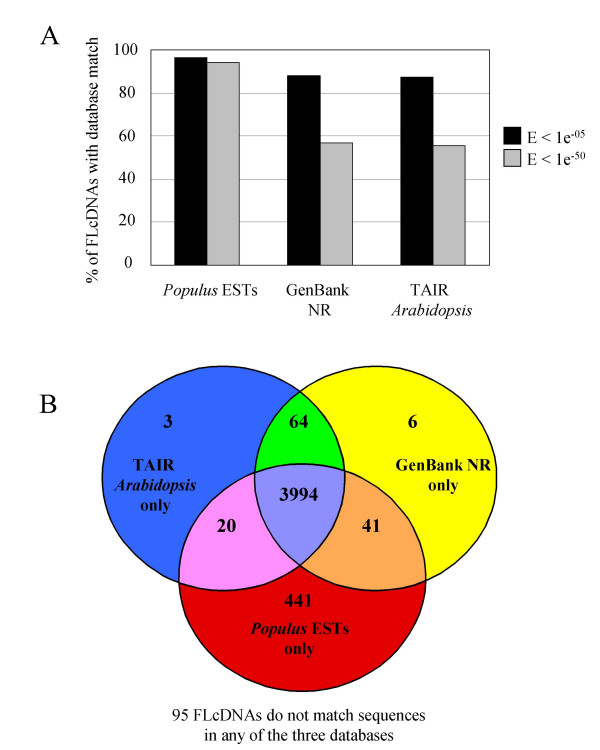
Sequence annotation of 4,664 high-quality poplar FLcDNAs against published databases. Panel A shows the percentage of FLcDNAs with similarity to entries in three databases using expect (E) value thresholds of < 1e-05 and < 1e-50: matches to previously published poplar ESTs (i.e., ESTs available in GenBank, excluding ESTs from this study) identified by BLASTN; amino acid sequences in the non-redundant (NR) division of GenBank identified by BLASTX; and The Arabidopsis Information Resource (TAIR) non-redundant Arabidopsis peptide matches identified by BLASTX. Panel B shows a Venn diagram of distinct and overlapping patterns of sequence similarity against the three databases (public poplar ESTs, TAIR, NR) at a BLAST E value threshold of < 1e-05. At this threshold, 95 poplar FLcDNAs had no similarity to sequences in any of the databases examined.